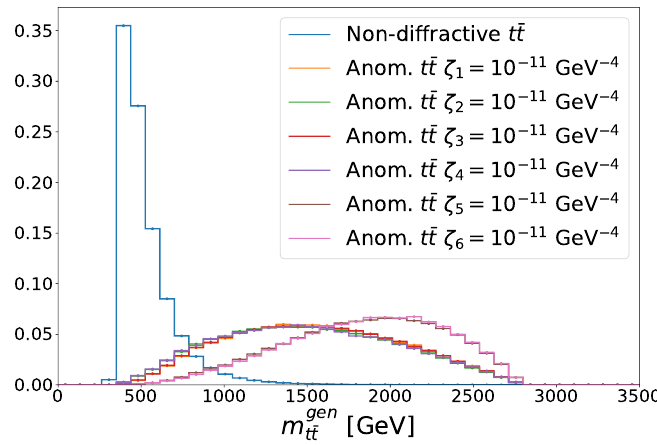
Figure 2. Mass of the t ¯ t system at generator level (stable-particle level). All histograms are normalized to